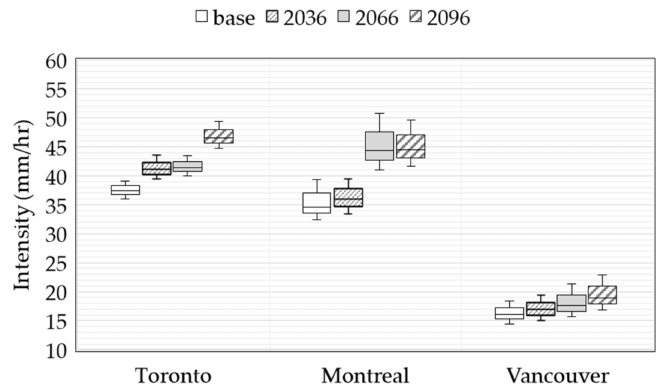
Figure 2. Comparison of rainfall intensity (for the 60 min duration and 10-year RP event) for the three cities in selected years.